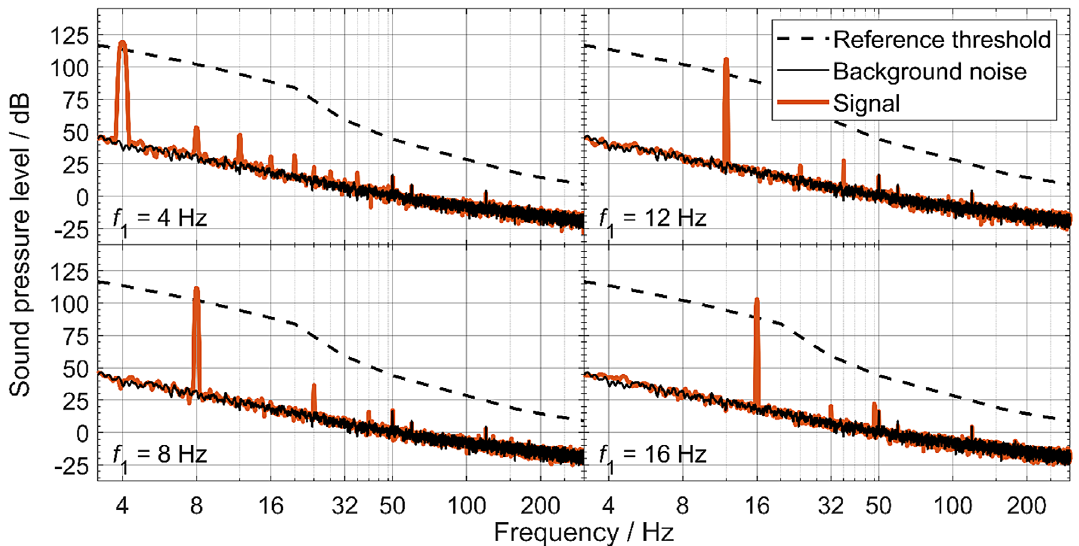
Figure 3. Magnitude spectra (orange solid lines) produced by the LDREPS in the occluded-ear simulator and measured with the ER- 10B+ microphone. Each panel shows the averaged spectrum for a pure-tone signal at a level above its reference threshold. The signal frequency, f 1 , is indicated in the bottom left corner of the panel. For comparison, the spectrum of a background noise measurement is also shown (dark gray solid line). In addition, the reference thresholds are shown as a black dashed line. The frequency spectra are limited to the frequency range from 3 Hz to 300